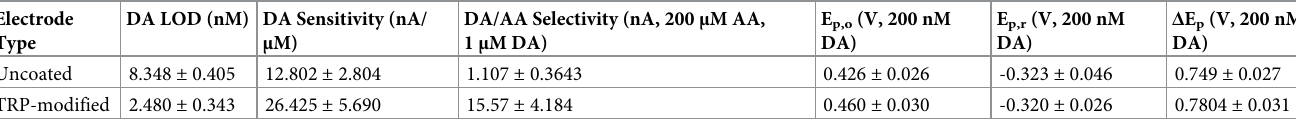
Table 1. Characterization of TRP-modified electrodes for detection of DA.